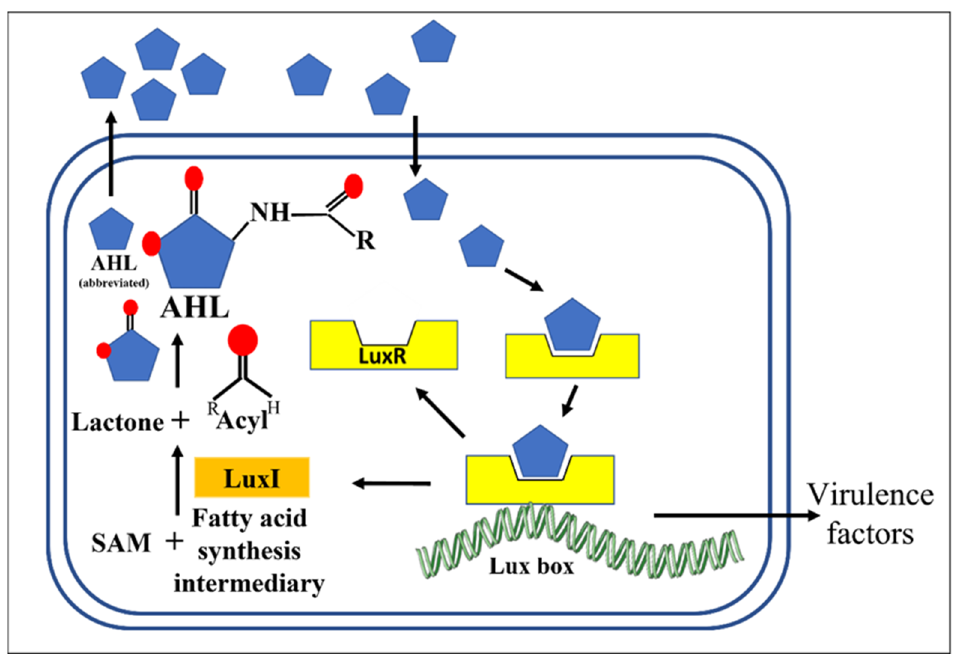
Figure 1. QS model in Gram-negative bacteria. Feedback loop involving the catalysis of acyl- homoserine lactone (AHL) by LuxI from S-adenosylmethionine (SAM) and fatty acid synthesis intermediaries. Upon re-entry into the cell, AHL combines with LuxR to initiate the expression of virulence factors, LuxI and